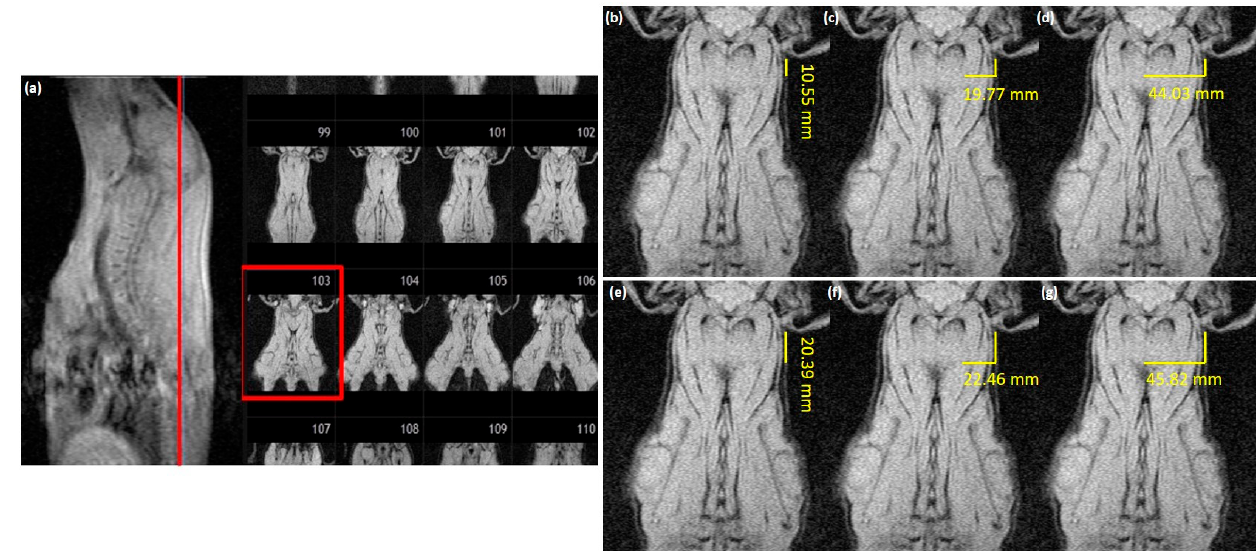
Figure 1. Demonstration of the measurements performed at the ear-base level. ( a ) Definition of the coronary image at the ear-base level (pig 1668; 23.5 kg, 94 days of age). ( b ) Defining the first injection point (OI_1), 10.55 mm behind the base of the ear. ( c ) Measuring the optimum injection point at 10.55 mm distance (OI_1) from the base of the ear (here: 19.77 mm). ( d ) Measuring the distance to the middle of the neck at 10.55 mm distance (MN_1) from the base of the ear (here: 44.03 mm). ( e ) Defining the second injection point (OI_2), 20.39 mm behind the base of the ear. ( f ) Measuring the optimum injection point at 20.39 mm distance (OI_2) from the base of the ear (here: 22.46 mm). ( g ) Measuring the distance to the middle of the neck at 20.39 mm distance (MN_2) from the base of the ear (here: 45.82 mm).